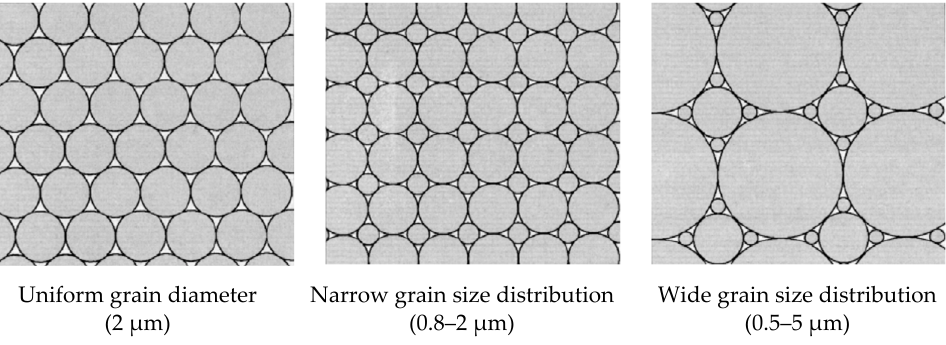
Figure 2. Comparison between single-grain and multigrain mixtures [29].